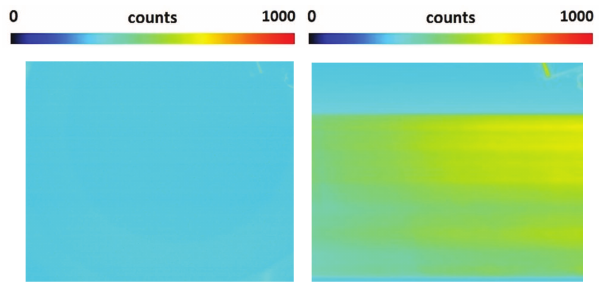
Fig. 4. Background and light sheet images, respectively from left